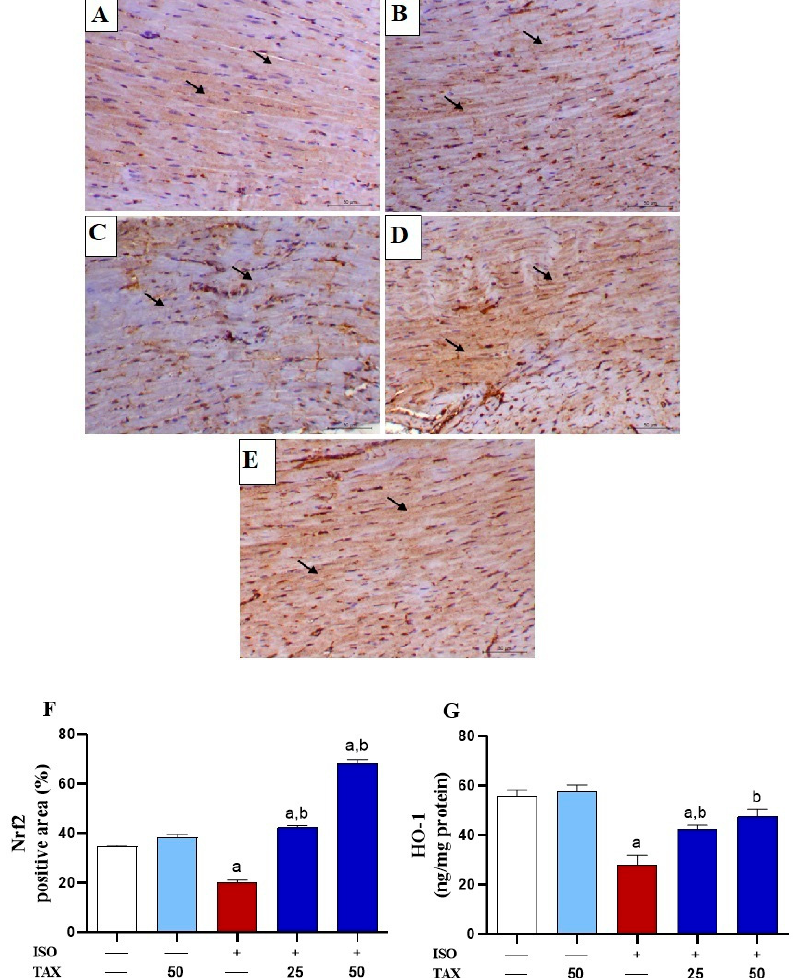
Figure 8. TAX upregulates Nrf2/HO-1 signaling in ISO-administrated mice. Images of the microscopic field of IHC labeled cardiac sections from ( A ) control and ( B ) TAX-treated mice, indicating obvious cytoplasmic immunostaining of Nrf2 within the myocardial fibers (arrows); ( C ) ISO-administered mice showing focal myocardial expression of Nrf2 (arrows); ( D ) ISO-injected mice pre-treated with 25 mg TAX demonstrating increased Nrf2 expression within the myocardial fibers (arrows); and ( E ) ISO-injected mice pre-treated with 50 mg demonstrating a noticeable rise in the myocardial expression of Nrf2 (arrows) (IHC, X200, Scale bar = 50 µm). ( F ) Analysis of the relative intensities of the images of IHC labeled myocardial Nrf2 demonstrating a significant increase in Nrf2 in the myocardium of mice treated with both doses of TAX before ISO injection. ( G ) TAX significantly attenuates myocardial levels of HO-1 in ISO-injected mice. Data are expressed as mean ± SEM, ( n = 6). Here, a indicates significant ( p < 0.05) vs. control, while b indicates significant ( p < 0.05) vs.